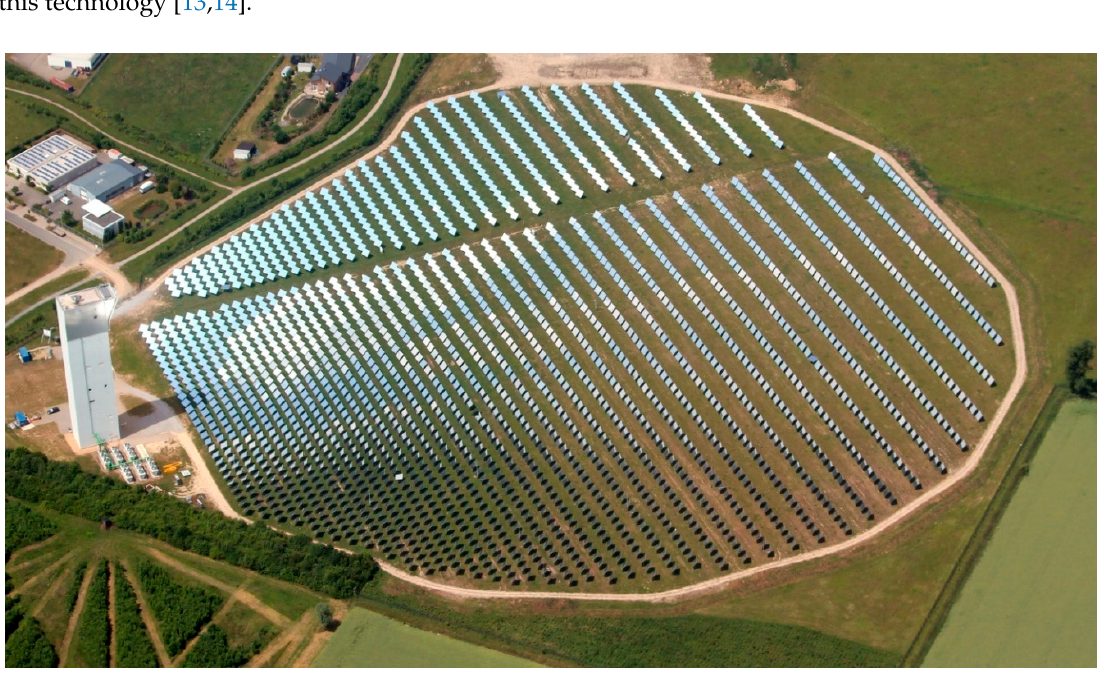
Figure 2. Jülich Solar Power Tower (Germany).